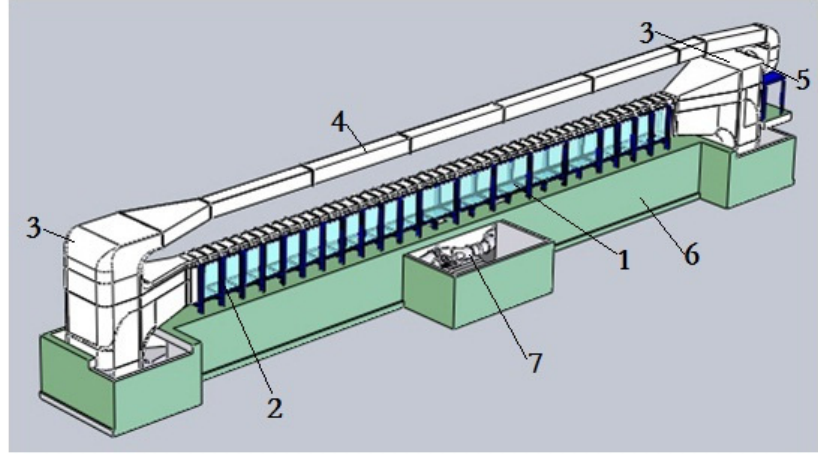
Figure 1. Schematic diagram of the wind–wave–current multifunctional experimental flume: (1) glass flume; (2) wavemaker; (3) booster chamber; (4) return duct; (5) fan; (6) flume foundation and bottom gallery; (7) return duct.